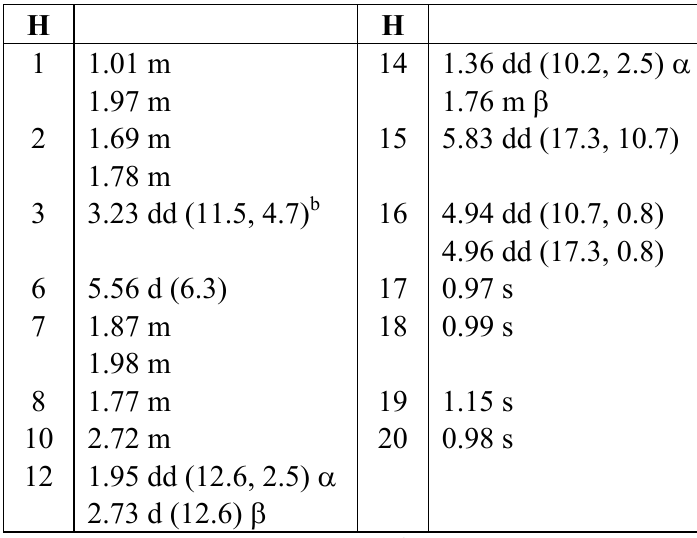
Table 1. 1 H-NMR data of 3 (600 MHz, CDCl